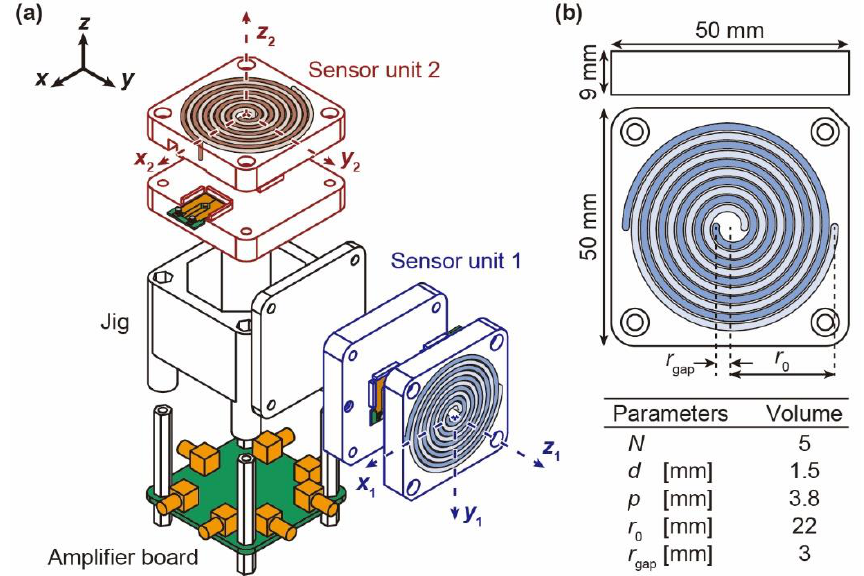
Figure 5. Proposed angular acceleration sensor consisting of two sensor units, an amplifier board, and a jig for connecting them. ( a ) Schematic illustration of the device assembly and the axis definition and ( b ) design of the sensor unit and parameter table of the spiral channel.